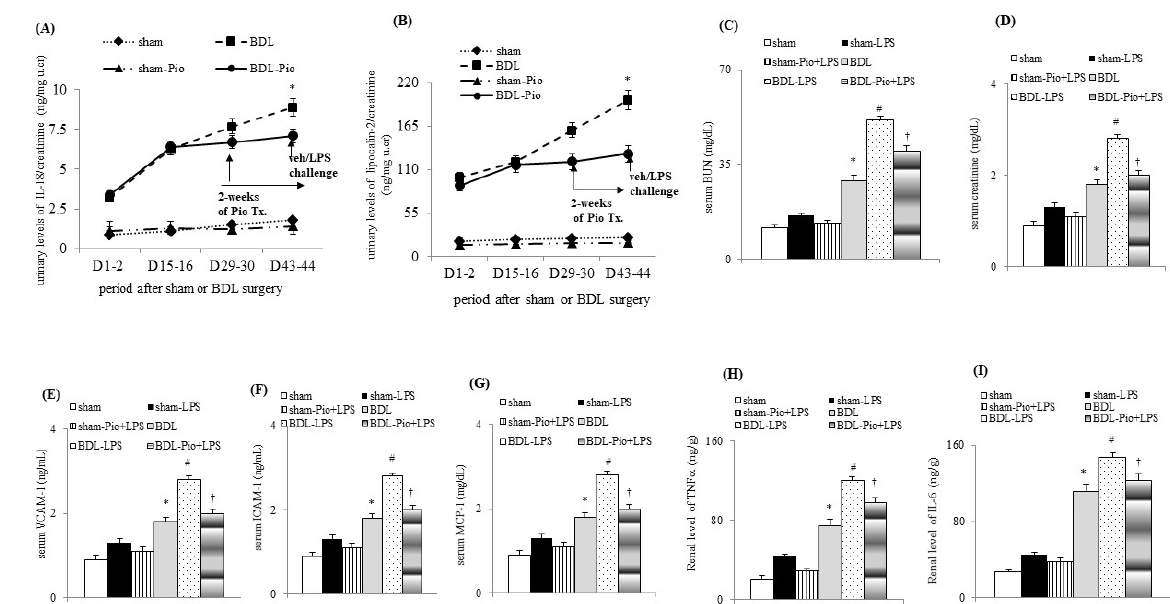
Figure 1. Chronic piogliotazone treatment attenuated chronic renal dysfunction in cirrhotic rats. ( A , B ) Urinary levels of renal injury markers including interleukin-18 (IL-18) and lipocalin-2; ( C , D ) serum BUN and creatinine; serum levels of ( E ) vascular cell adhesion molecule-1 (VCAM-1), ( F ) intracellular adhesion molecule-1 (ICAM-1), ( G ) monocyte chemoattractant protein-1 (MCP-1); renal levels of ( H ) TNF α , tumor necrosis factor α (TNF α ) and ( I ) interleukin-6 (IL-6); * p < 0.05 sham vs. BDL group; # p < 0.05 vs. BDL vs. BDL-LPS group; † p < 0.05 vs. BDL-pio+LPS vs. BDL-LPS group.